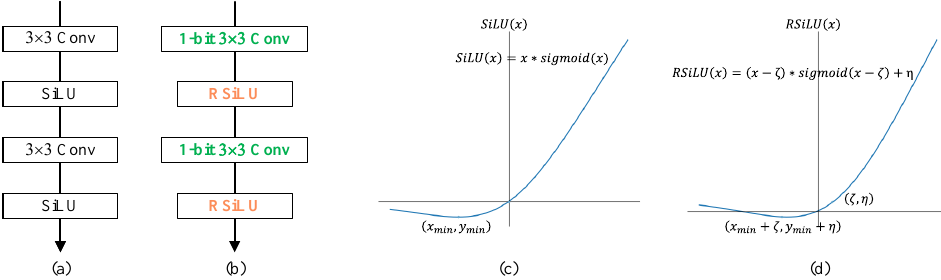
Figure 3. ( a ) Building blocks of U-Net; ( b ) basic unit for proposed U-BiNet; ( c ) SiLU activation function; and ( d ) proposed RSiLU activation function with learnable